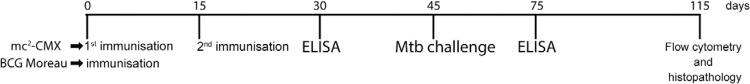
: timeline scheme of the experimental design. Mice were immunised once with
Bacillus Calmette-Guérin (BCG) [106 colony-forming unit (CFU)/mouse] or twice
with mc2-CMX (107 CFU/mouse) with 15 days interval. Thirty days after first
immunisation, blood was collected from mice and assayed in an ELISA for IgG1
and IgG2a antibodies against CMX. Forty-five days after initial immunisation,
mice were intravenously challenged with Mycobacterium
tuberculosis (Mtb) H37Rv strain (107 CFU/mouse). Thirty days after
challenge, blood was collected for ELISA. Seventy days after challenge, mice
were euthanised and organs were removed for flow cytometry and
histopathological analyses.